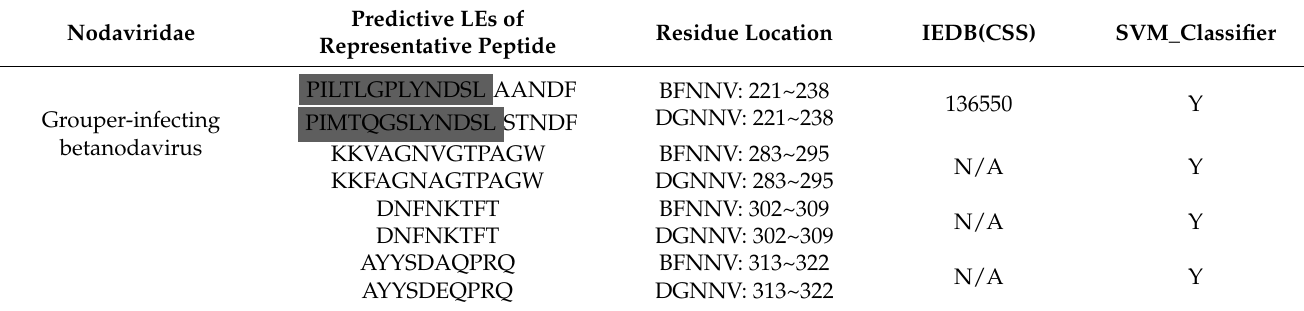
Table 2. Predicted LEs of grouper-infecting